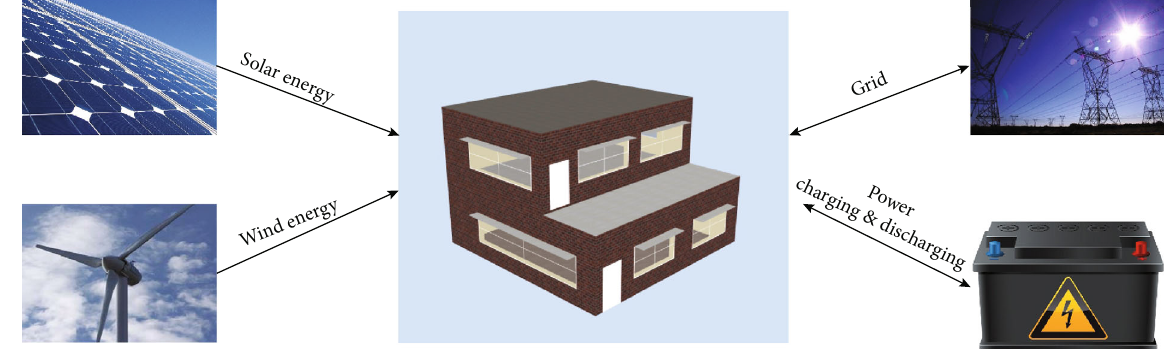
Figure 1: Energy exchange of the studied building with renewable resources, battery, and network.